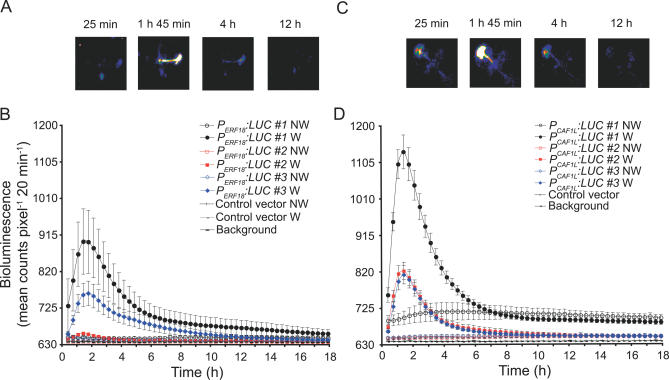
In Vivo Monitoring of RWR Gene Induction Following Wounding(A) Image of an individual PERF18:LUC #3 transgenic plant over time.(B) Luciferase activity of three independent transgenic lines expressing transcriptional PERF18:LUC fusions. Luciferase activity was calculated in wounded leaves (single leaf per plant) and NW leaves (on NW plants). Data are means of n = 12 ± SEM.(C) Image of an individual PCAF1L:LUC transgenic plant over time.(D) Luciferase activity of three independent transgenic lines expressing transcriptional PCAF1L:LUC fusions. Luciferase activity was calculated in wounded leaves (single leaf per plant) and NW leaves (on NW plants). Data are means of n = 18 ± SEM.